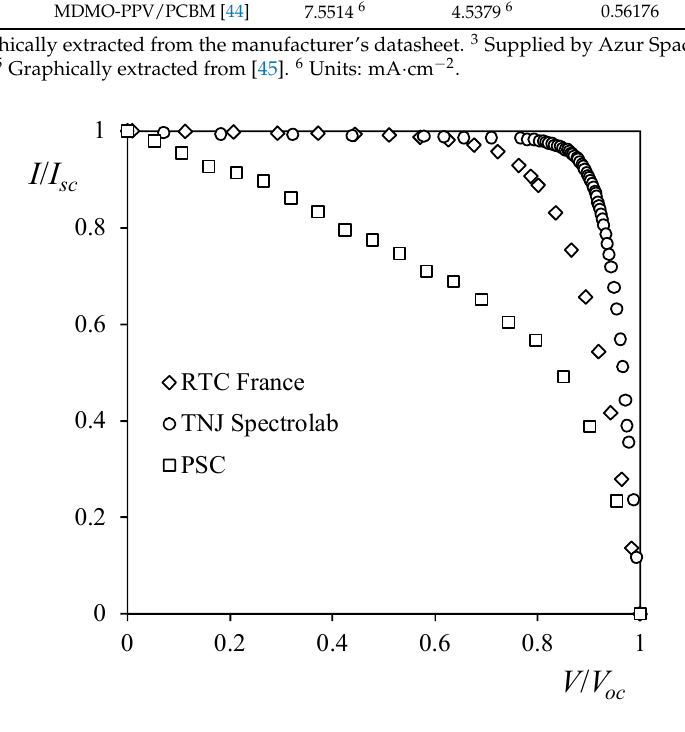
Figure 3. Non-dimensional current–voltage curves for three solar cells based on different technologies (RTC France: silicon; TNJ Spectrolab: Ga–As triple junction; PSC: plastic solar cell. See Table 2).